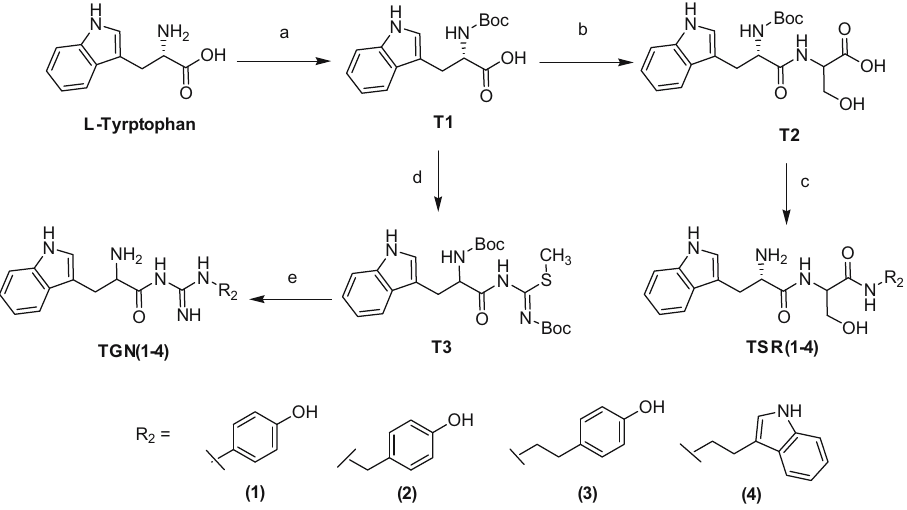
Scheme 1: The scheme of synthesis of compounds in the TSR and TGN series: ( a ) Boc 2 O, NaOH, THF/H 2 O ( 1:1 ) , rt, 18 h; ( b ) ( i ) L - serine methyl ester hydrochloride, HBTU, DIPEA, DMF, rt, 18 h, ( ii ) MeOH, KOH, rt, 3 h; ( c ) ( i ) NH 2 - R 2 , HBTU, DIPEA, DMF, rt, 18 h, ( ii ) TFA:EtOAc ( 1:1 ) , rt, 3 h; ( d ) N - tert - butoxycarbonyl ( Boc )- protected 2 - methyl - 2 - thiopseudourea ( 1a ) , HATU, NMM, DMF, rt, 18 h; and ( e ) ( i ) NH